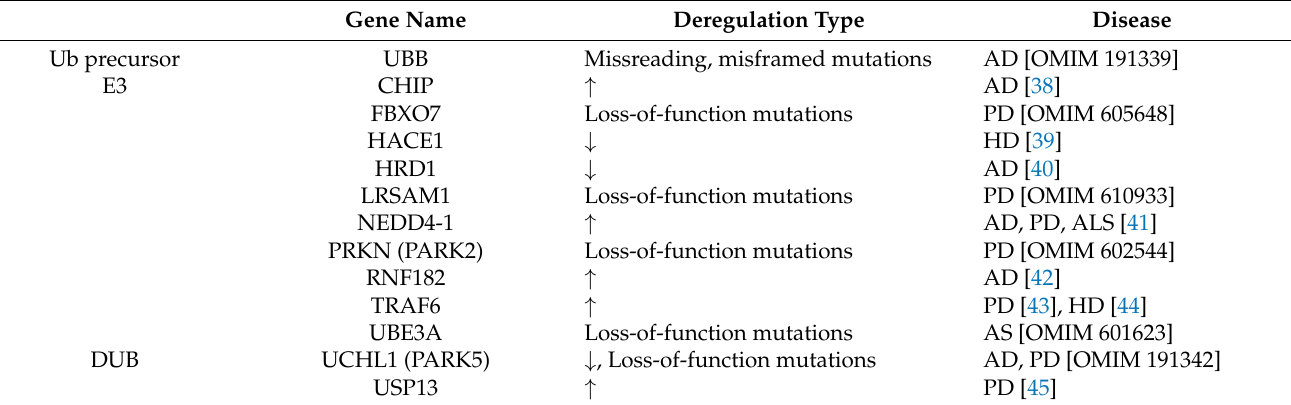
Table 3. Examples of neurodegenerative disease-related UPS components. The disease information for each gene referenced OMIM (https://www.ncbi.nlm.nih.gov/omim). (All accessed on 1 March